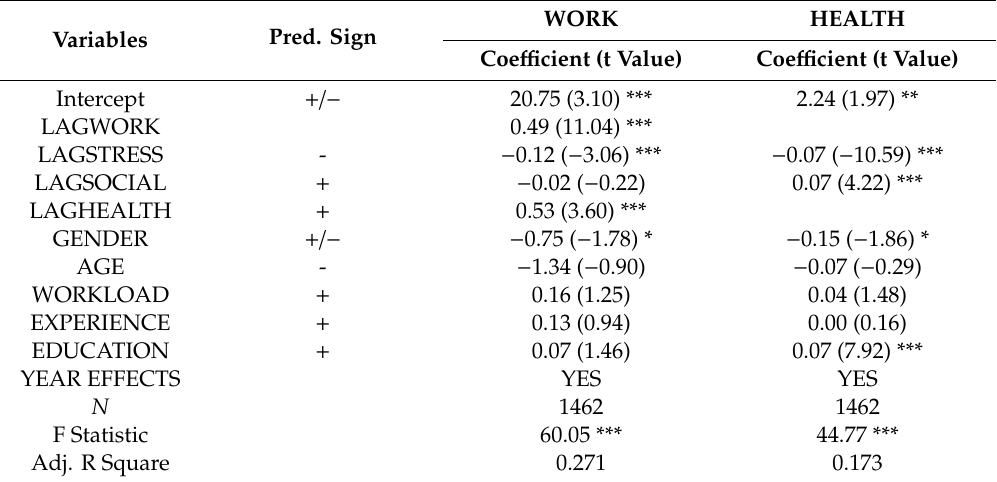
Table 8. Regression analysis of work ability with lagged independent